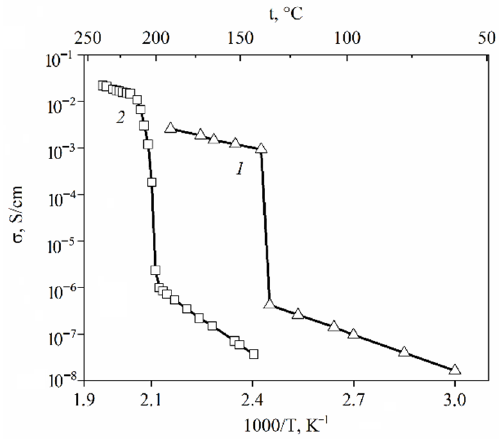
Figure 42. Temperature dependences of proton conductivity of CsHSO 4 (curve 1 [116]) and CsH 2 PO 4 (curve 2 [115]), adapted from [115,116].